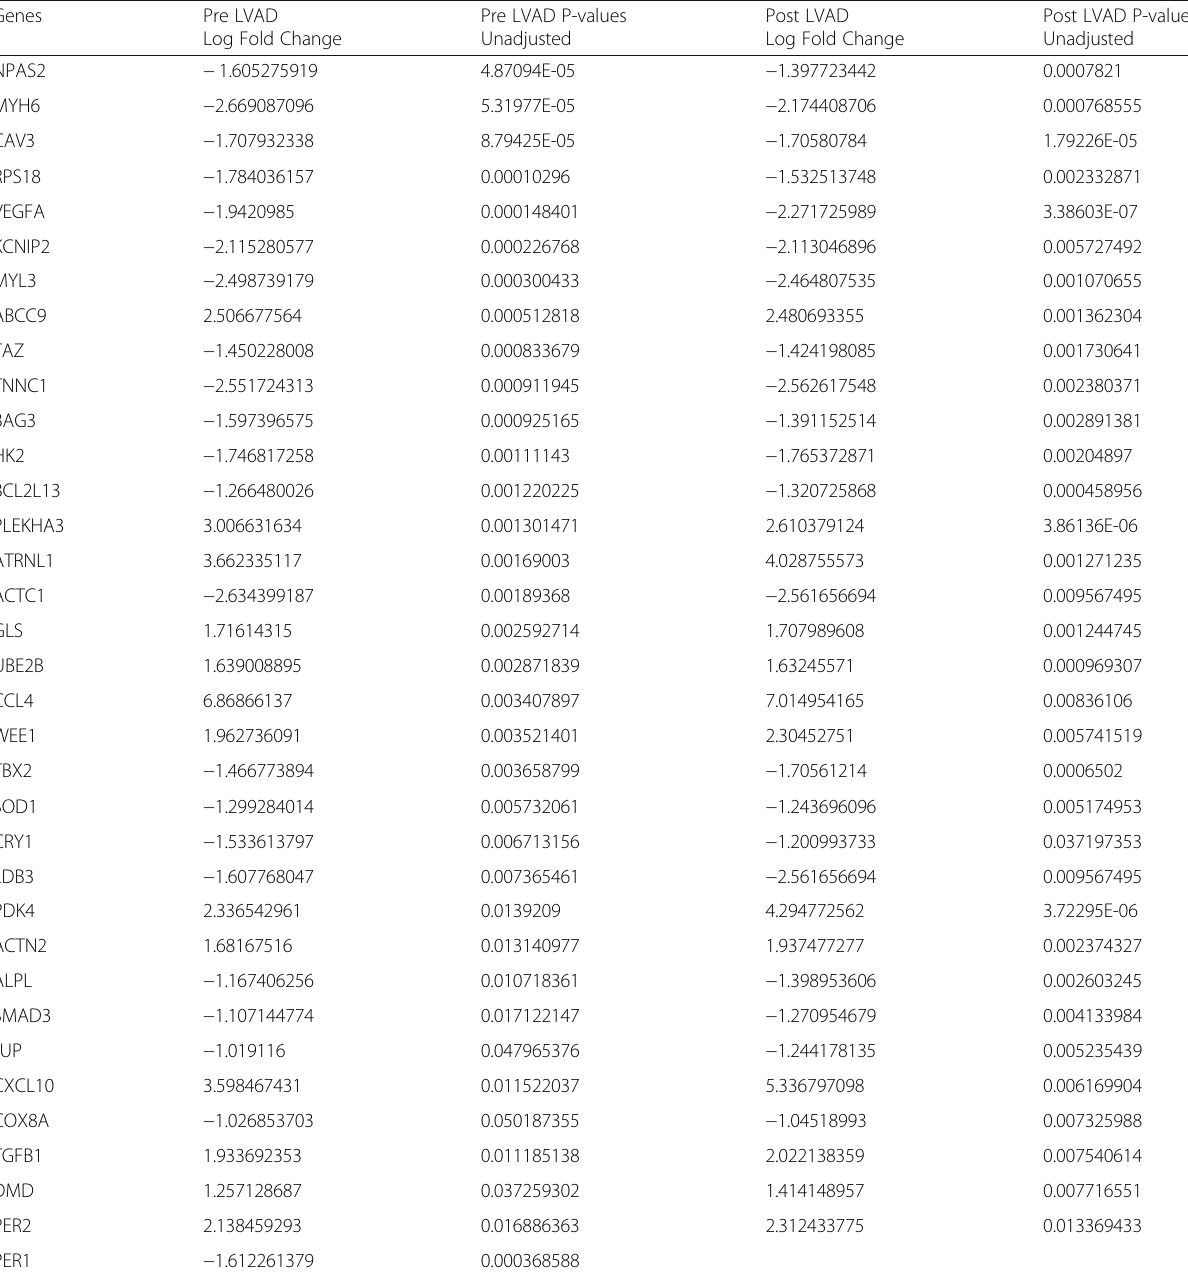
Table 2 Expressions of same genes from pre and post LVAD patients were compared with control (normal heart